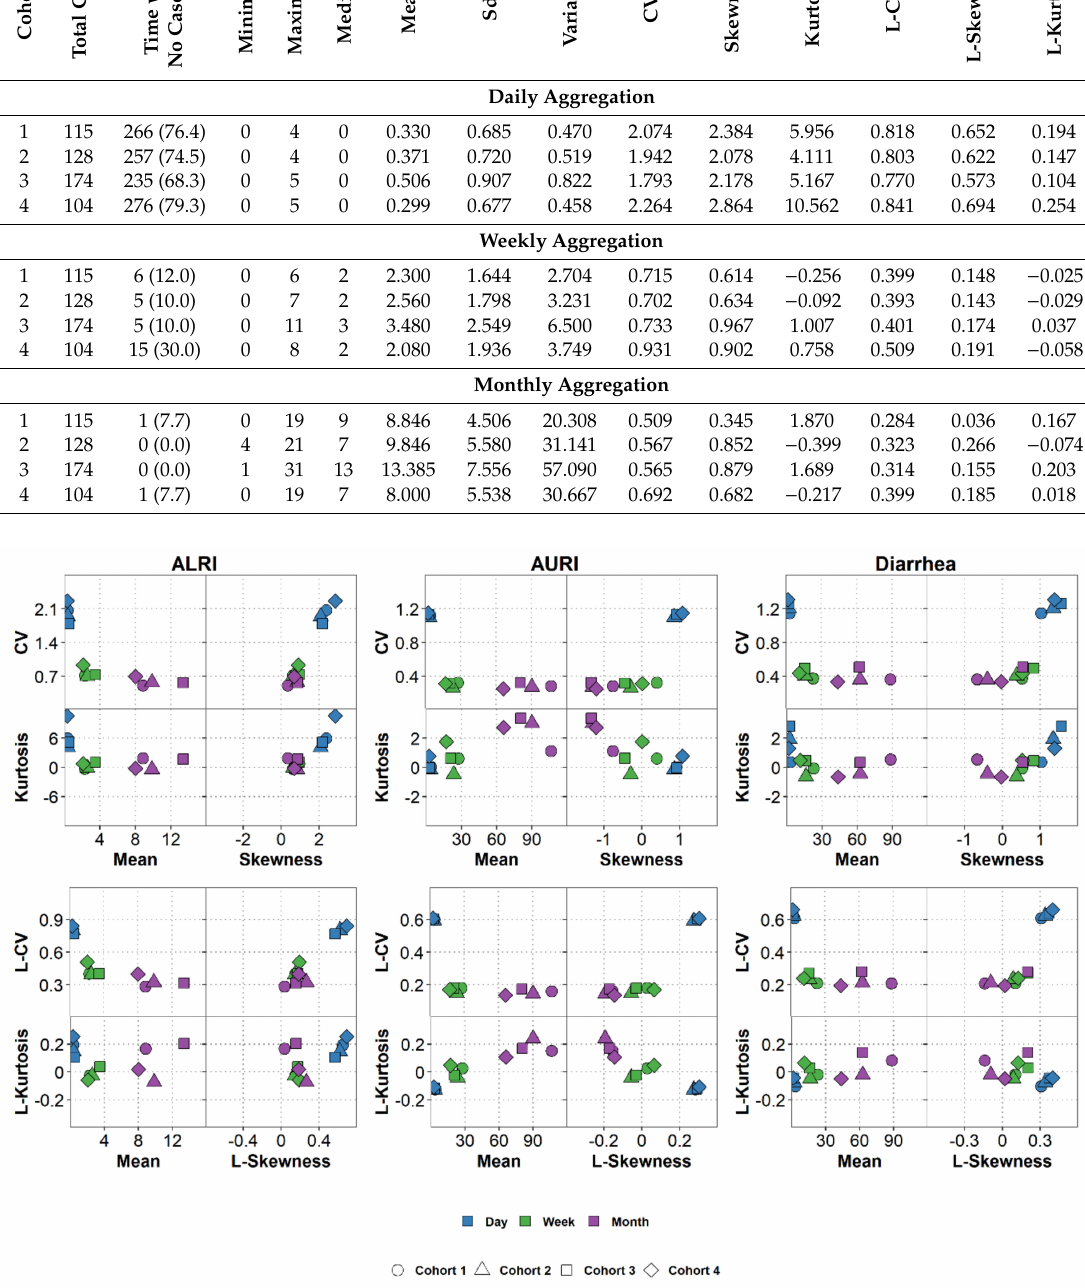
Figure 4. Plots of moments and L-moment ratios of daily, weekly, and monthly counts of AURI, ALRI, and